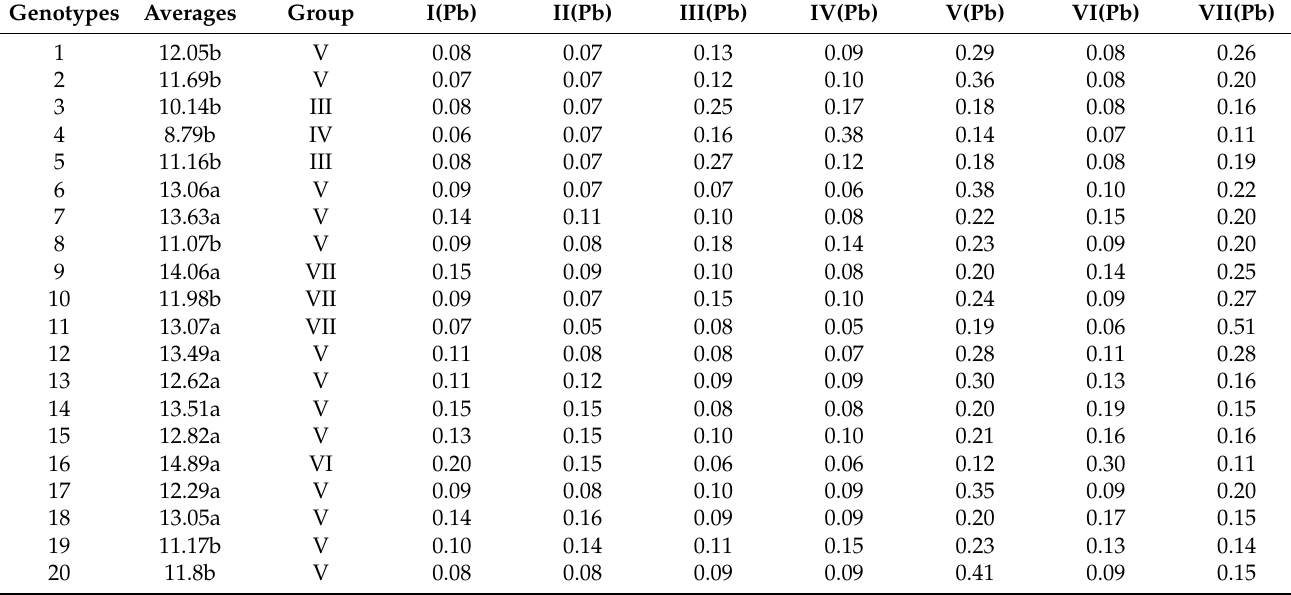
Table 11. Estimates of fiber productivity, classification of sugarcane genotypes in one of the seven groups proposed by the modified centroid method and probability associated with the classification of each